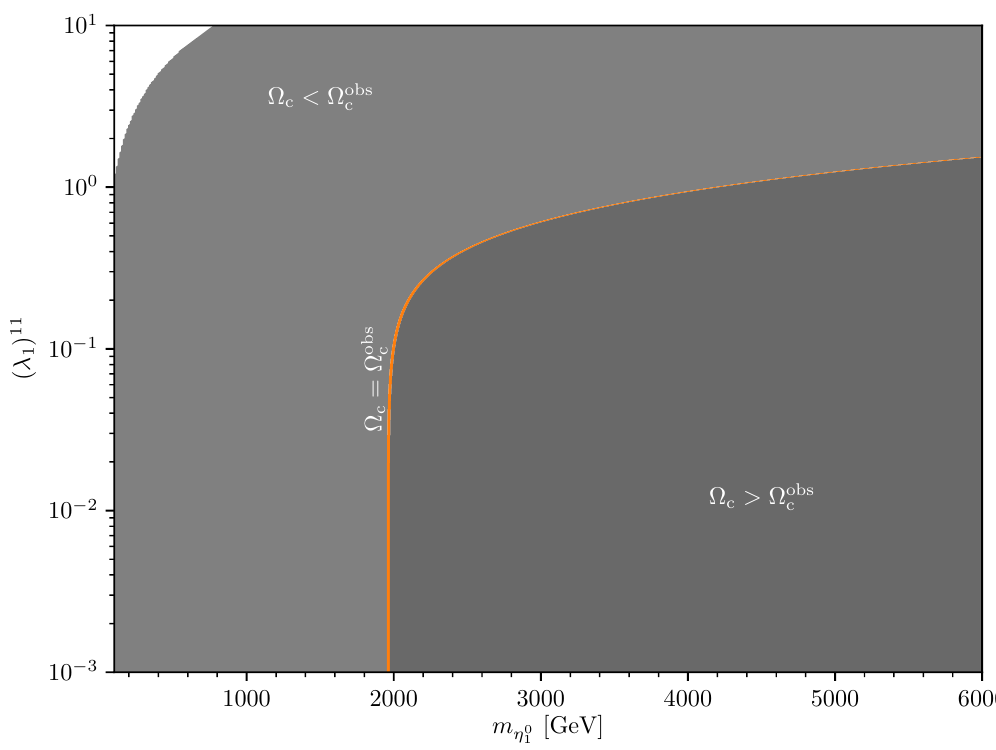
Figure 3 . The observed relic density contour ((cid:10) obs and too large (below) relic density, as a function of the triplet scalar DM mass m coupling ( (cid:21) 1 ) 11 . Here, we assume only one generation of